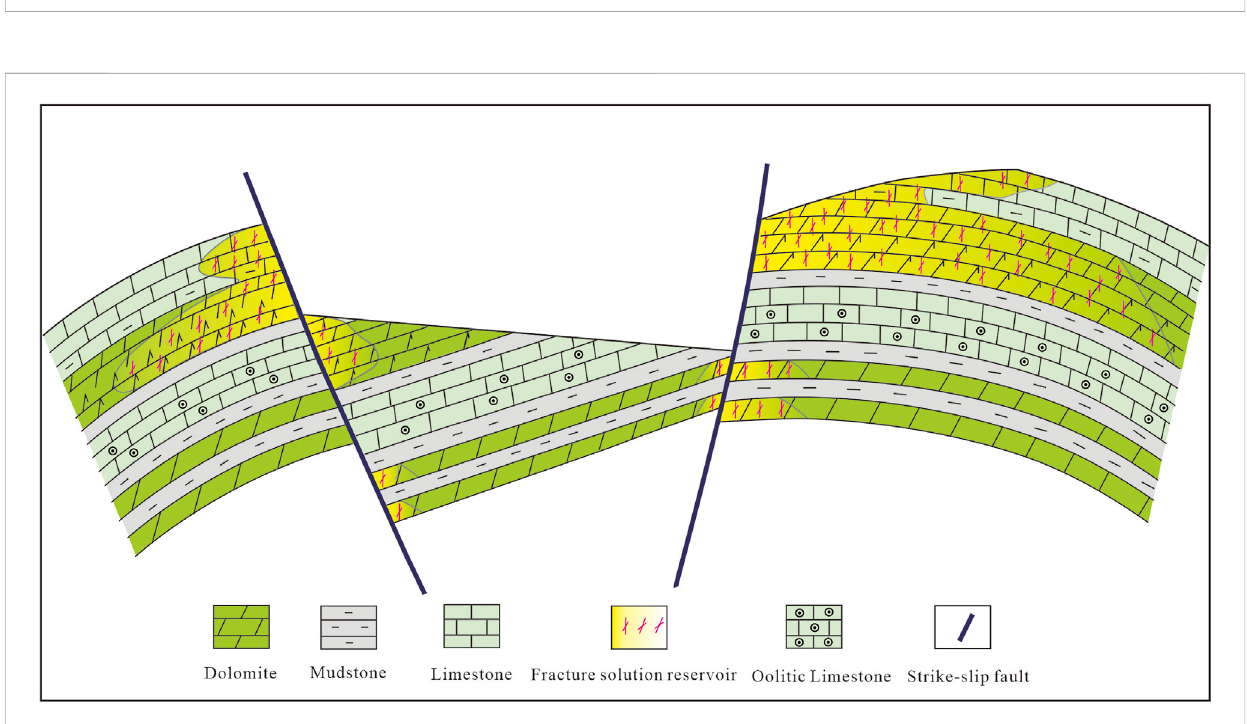
Development model of fractured-dissolved reservoirs in CFD